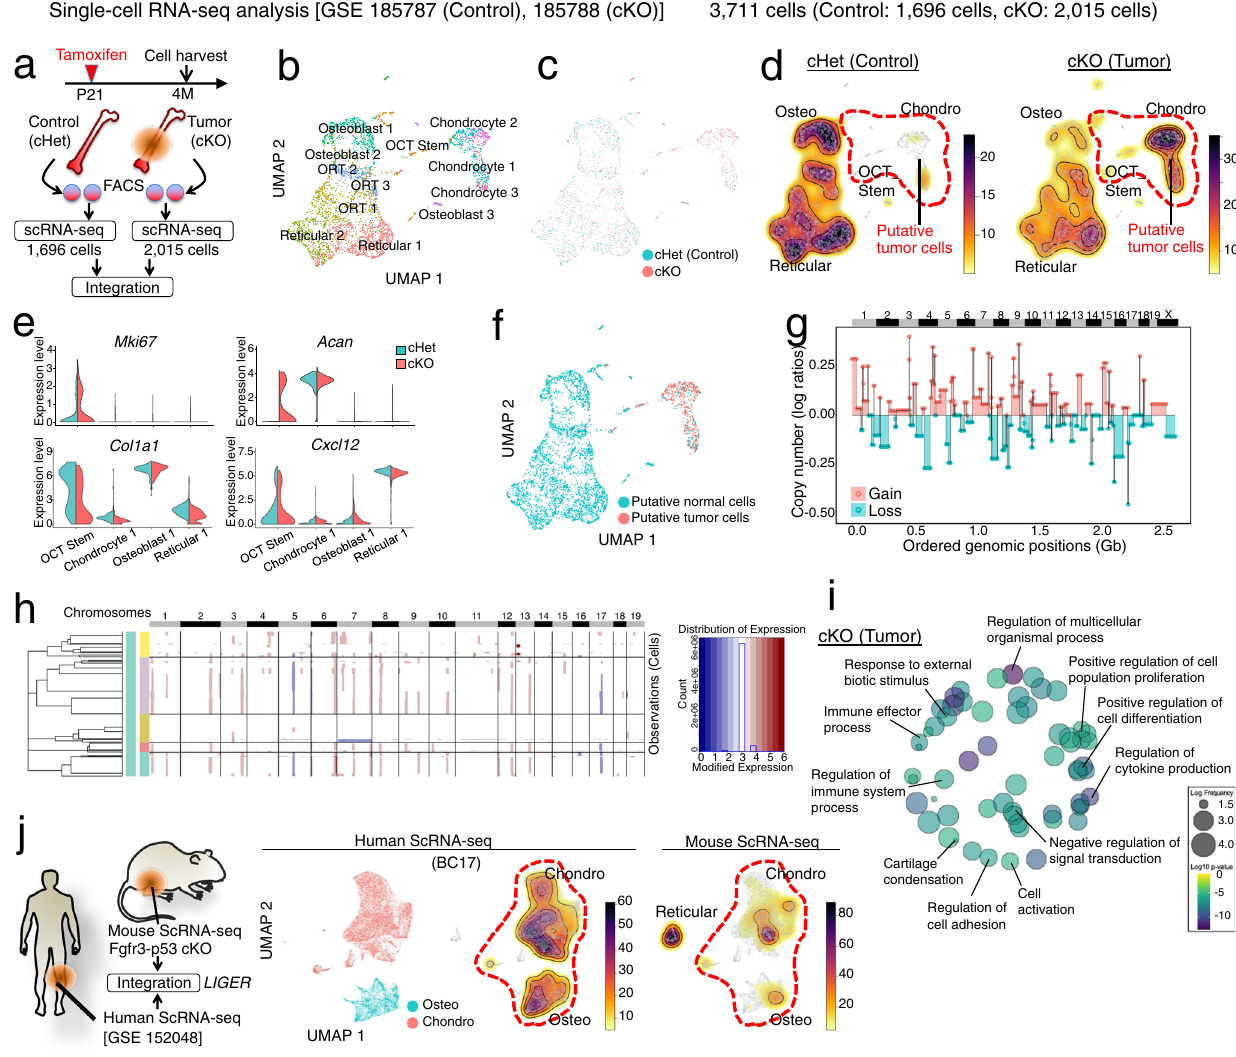
Fig. 8 | Single-cell characterization ofFgfr3 + cell-derivedmouseosteosarcoma- like lesions. a – e Single-cell RNA-seq analyses of osteosarcoma-like lesions. a Diagram for LIGER data integration of single-cell RNA-seq datasets of lineage- traced tdTomato + cells isolated from Fgfr3-creER ; Trp53 fl /+ ; R26R tdTomato (Fgfr3-p53 cHet)and Fgfr3-creER ; Trp53 fl / fl ; R26R tdTomato (Fgfr3-p53cKO)femursat4M(pulsedat P21).Fgfr3-p53cHet:1696cells,Fgfr3-p53cKO:2015cells,Total:3711cells. b UMAP visualization of major sub-clusters of the LIGER-integrated dataset. c UMAP visua- lizationoftwodatasetsintegratedbyLIGER.Blue:cHet,red:cKO. d Densityplotsof Fgfr3-p53 cHet (left) and Fgfr3-p53 cKO (right) in the integrated space. Red dotted contour: OCT Stem and Chondrocyte-like clusters predominantly contributed by Fgfr3-p53 cKO cells. e Split violin plots for Mki67 (proliferation), Acan (Chondro), Col1a1 (Osteo), and Cxcl12 (Reticular) in representative clusters (OCT Stem, Chondrocyte 1, Osteoblast 1, and Reticular 1) between cHet (blue) and cKO (red). n =148(OCTStem), n =26(Chondro1), n =290(Osteo1), n =469(Reticular1)cells incHet. n =426(OCTStem), n =125(Chondro1), n =177(Osteo1), n =434(Reticular 1) cells in cKO. f UMAP-based visualization of putative aneuploid cells inferred by